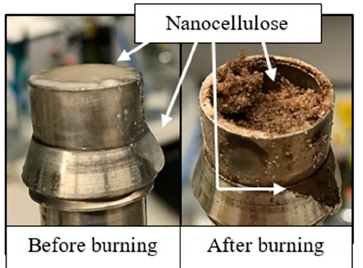
Figure 15. Inlet of sandpack flooded by 0.5 wt. % CNC (USDA) in 1.0 wt. % NaCl. ( Left ) Thin film of nanocellulose gel sits on the top of the sand. ( Right ) Areas containing nanocellulose produced black ash after burning.